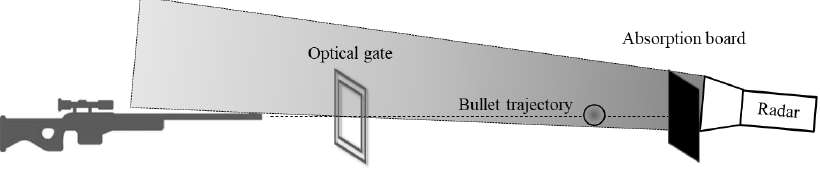
Figure 4. Illustration of the radar position; the radar is placed opposite to the gun.